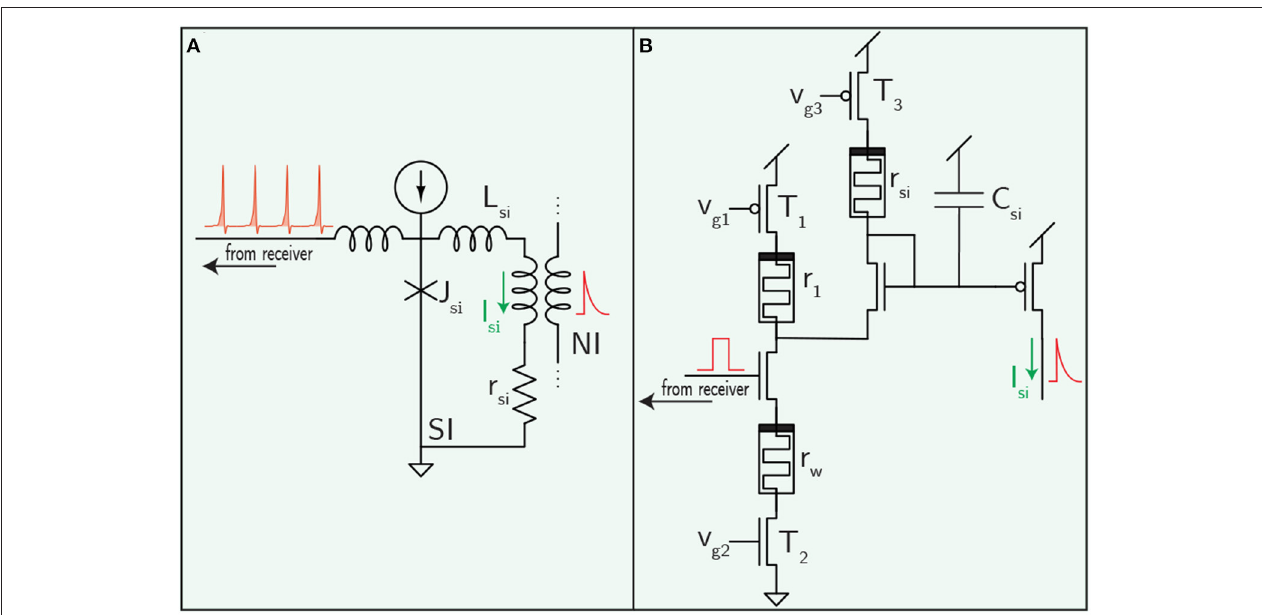
FIGURE 4 | Synaptic filtering circuits for the superconductor (A) and semiconductor (B) cases. Weighting in the superconducting case was shown in Figure 2 . The memristor-integrated DPI circuit pictured here is introduced in Ref. ( Dalgaty et al.,